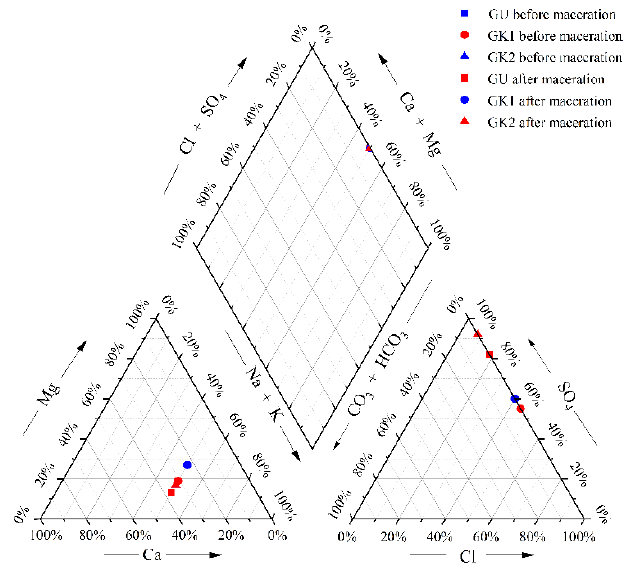
Figure 6. The main hydrochemical ions variation relationship diagram throughout the experiment and the difference from beginning to end. (a. Graph of the proportion change of water chemical ions